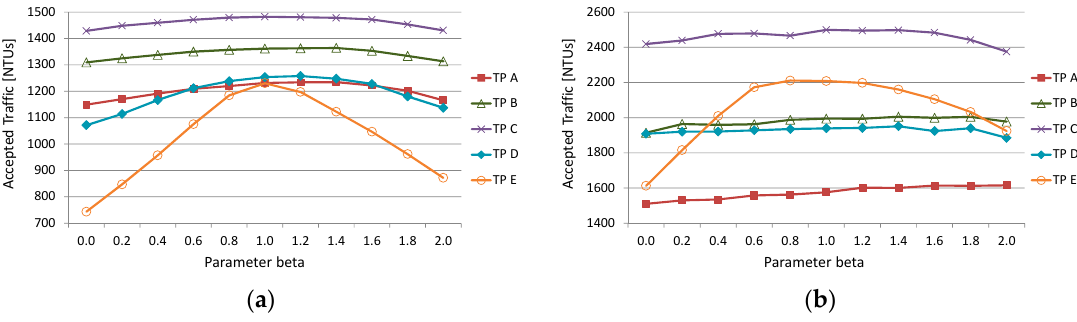
Figure 6. Tuning of the SAUR algorithm—accepted traffic as a function of tuning parameter β for the US26 network with different traffic profiles: ( a ) 10,000 transponders, ( b ) 20,000 transponders.